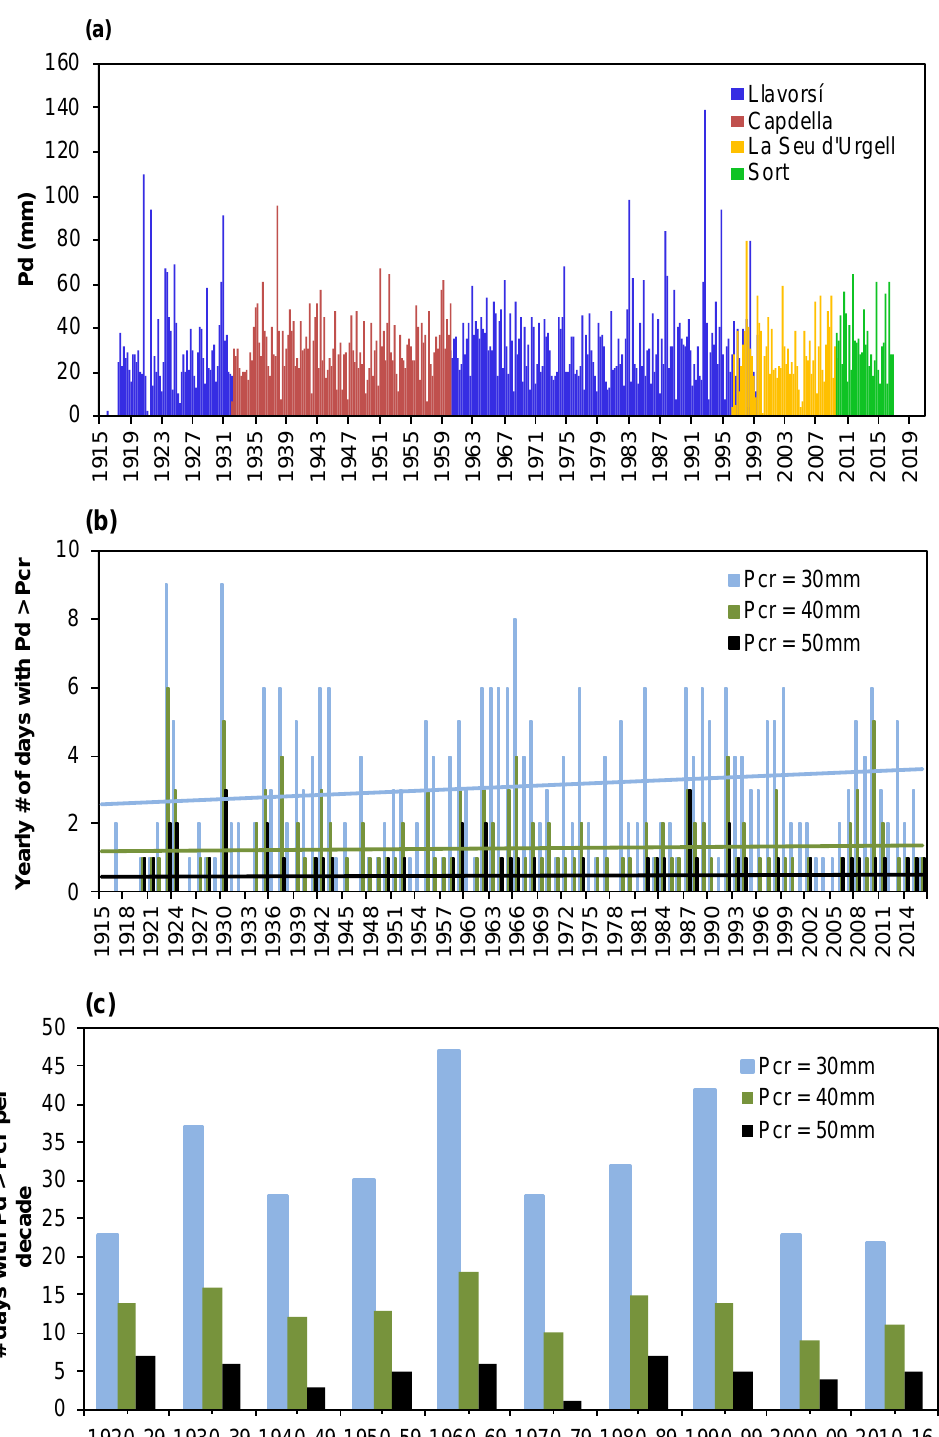
Figure 6. Analysis of rainfall trends for the Portain é area. ( a ) Complete time series of daily rainfall (P d ). ( b ) Number of heavy rainfall events exceeding critical daily rainfall (P cr ) per year. Linear regression models are included with the same colour as the bars. ( c ) Number of heavy rainfall events exceeding P cr per decade.